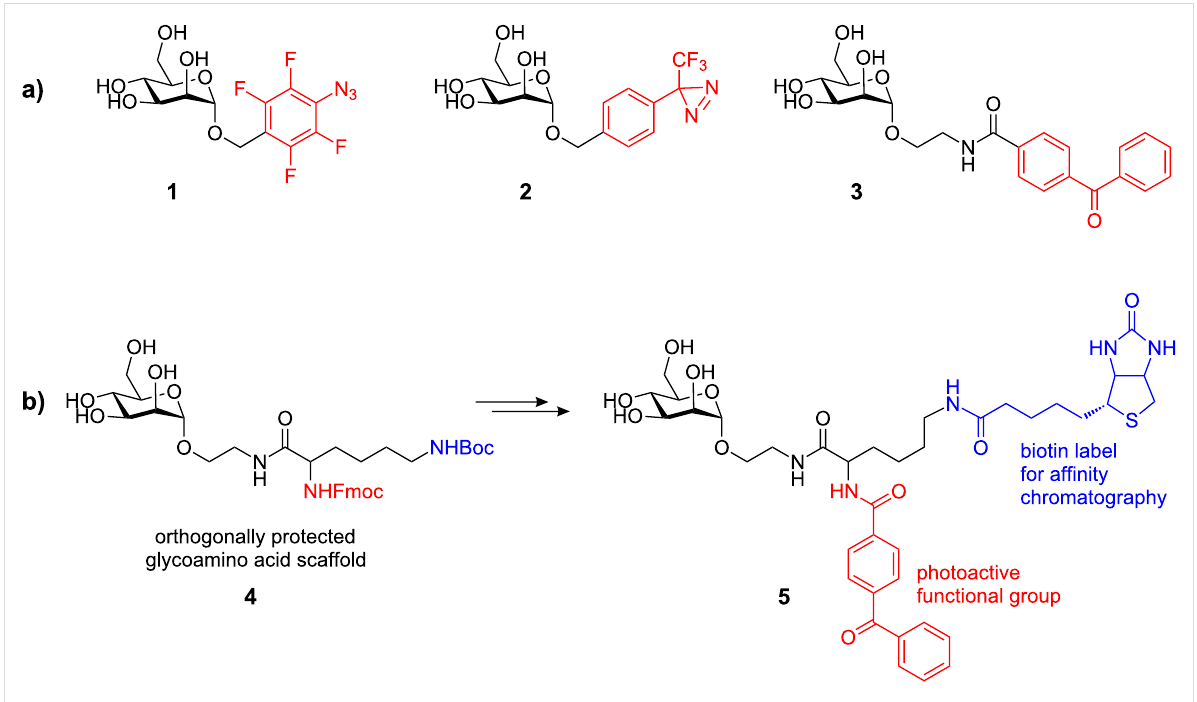
However, other binding experiments performed with a multi- tude of synthetic as well as natural mannosides and oligo- mannosides are not in complete agreement with just one mono- valent carbohydrate binding site on the FimH protein